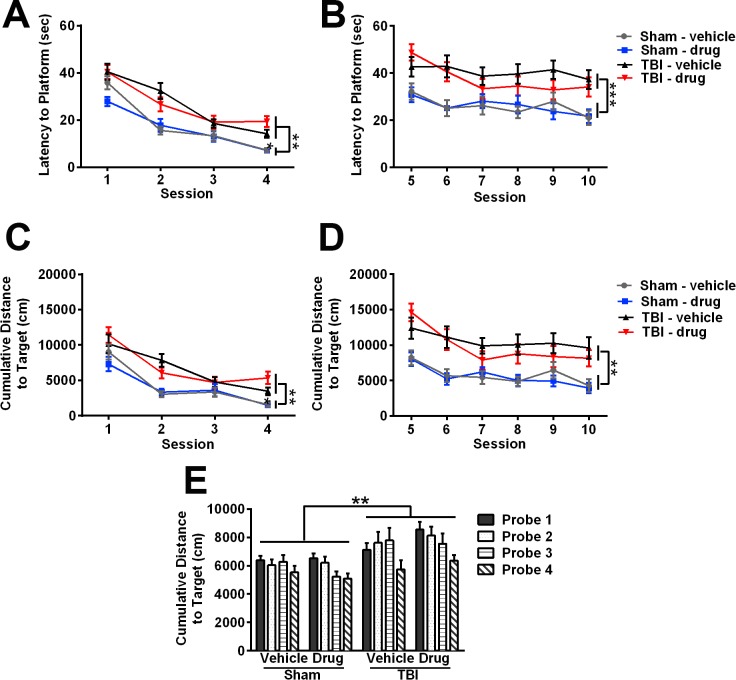
Cognitive deficits detected in the Morris water maze (MWM) at adulthood after pediatric TBI, are unaffected by gelatinase inhibition.(A) During the visible sessions, quantification of latency to reach the platform revealed an impairment in task learning by TBI mice compared to sham controls (multivariate ANOVA overall effect of TBI, **p<0.01). (B) During hidden platform sessions, injured mice also showed a greater latency to reach the platform as compared to sham controls (overall effect of TBI, ***p<0.001), indicating an impairment in spatial memory. Cumulative distance to the target was also quantified as an alternative outcome measure (C-D), which similarly detected impairments in task performance and spatial memory in TBI mice compared to sham controls (overall effect of TBI, **p<0.01). (E) Probe trial performance was quantified as cumulative distance to the target. Injured mice traveled a greater distance to reach the target quadrant compared to sham controls (RM ANOVA, overall effect of TBI, **p<0.01) (n = 15/group). Bars represent mean + sem and values represent mean ± sem.